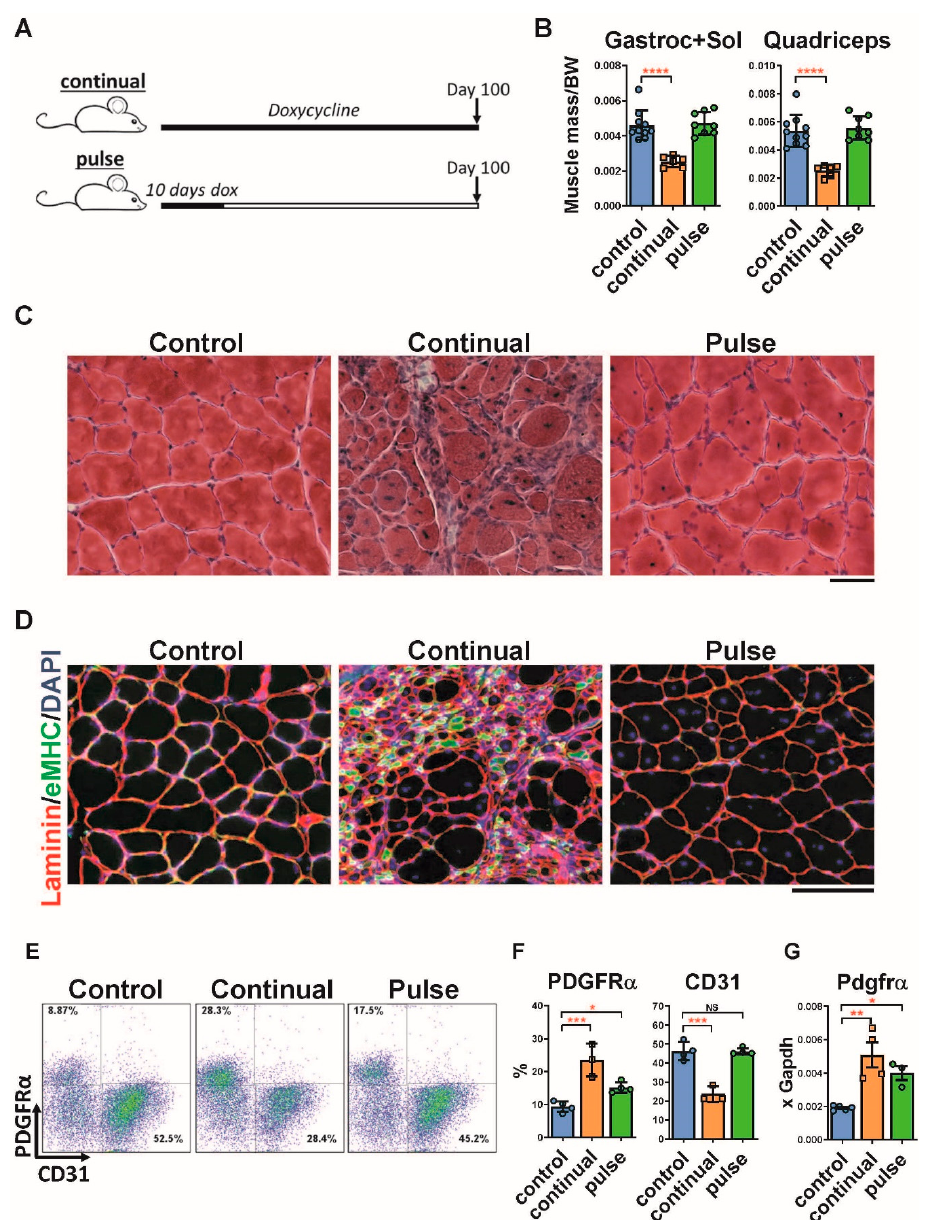
Figure 1. Elevated FAPs in the muscle after a pulse of DUX4. ( A ). Scheme of doxycycline induction protocol in iDUX4pA;HSA mice. Mice in one arm of the experiment continuously received doxycycline (chow containing 625 mg/kg doxycycline) for 100 days. This group is named ‘continual’. In the other arm, mice were fed with doxycycline chow for the first 10 days of the experiment and for the following 90 days received standard (doxycycline-free) chow. This group is referred to as ‘pulse’. ( B ). Mass of different muscles normalized to body weight from iDUX4pA;HSA mice continuously or pulse fed with doxycycline food. Data represent mean ± SEM, **** p < 0.0001 by one-way ANOVA, n = 6. ( C ). Representative H&E staining on quadriceps from control and iDUX4pA;HSA after continual or pulse induction with doxycycline. Scale bar 100 µ m. ( D ). Immunofluorescence (IF) staining (bottom panel) for laminin (red), embryonic myosin heavy chain (eMHC, green) and nuclei (DAPI, blue) on the slides presented in ( C ). ( E ). Representative FACS plots for PDGFR α and CD31-expressing cells in the muscle of iDUX4pA;HSA mice pulse- or continuously treated with doxycycline. ( F ). Summary of the FACS analyses represented in ( E ). Data are expressed as mean ± SEM; * p < 0.05, *** p < 0.001, by one way ANOVA, n = 4. ( G ). RT-qPCR for Pdgfra in gastrocnemius from continuously and pulse induced mice. Data represent mean ± SEM; * p < 0.05, ** p < 0.01, by one-way ANOVA, n =